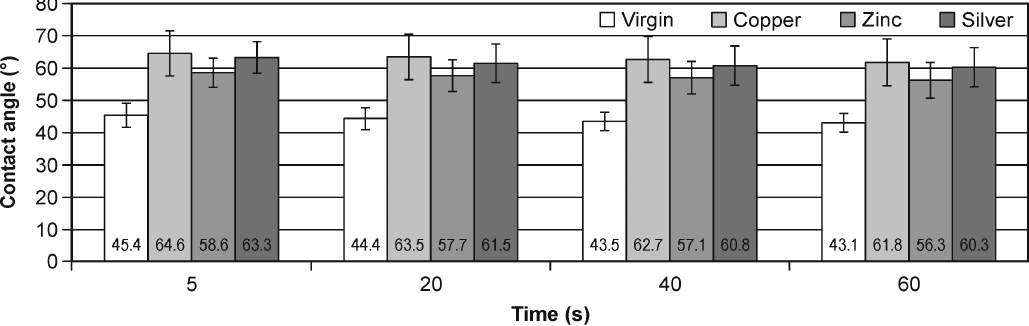
Figure 3. The change of the contact angle in the time for virgin and implanted cellulose.